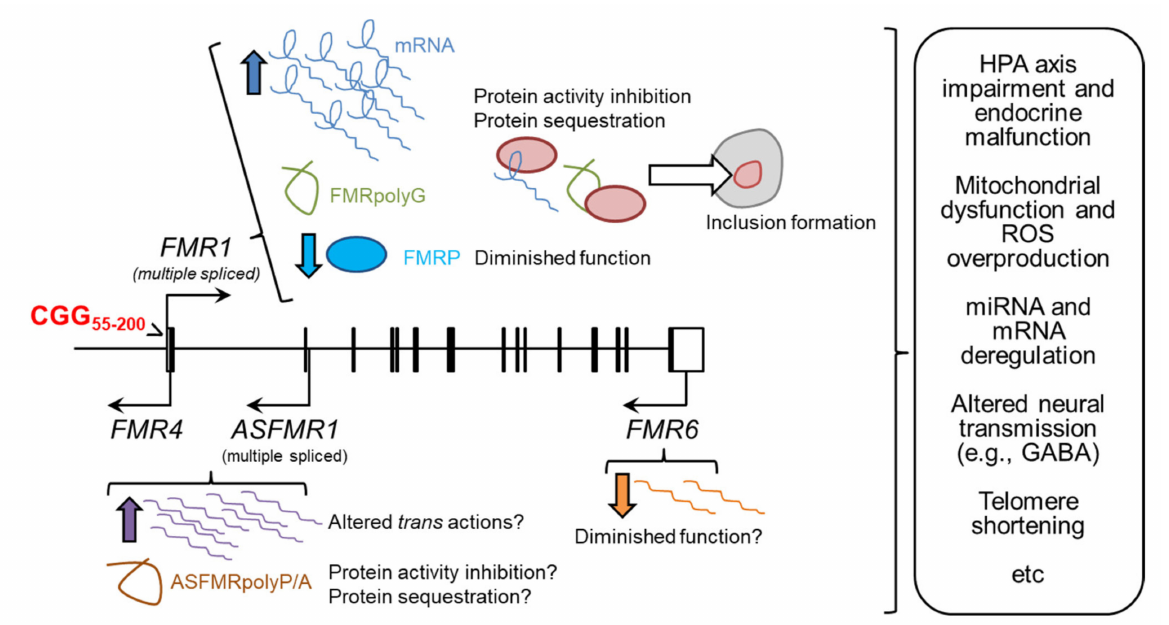
Figure 1. Summary of the molecular mechanisms proposed for the PM of the FMR1 gene. Arrows indicate in- creases/decreases of RNA ( FMR1 and the long non-coding RNAs ASFMR1 / FMR4 and FMR6 ) or protein (FMRP) in PM carriers compared to controls. Pink ovals represent free proteins that interact/are sequestered/are aggregated by the CGG hairpin of the FMR1 mRNA and/or FMRpolyG